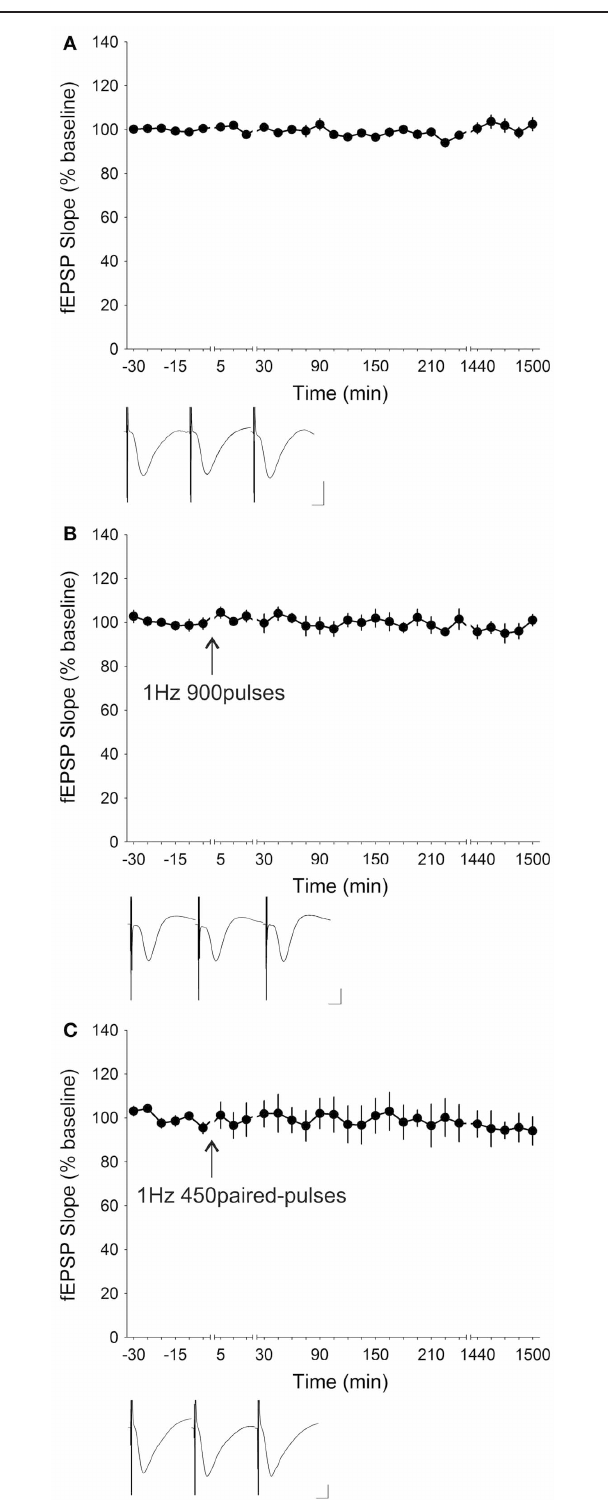
FIGURE 2 | Low-frequency stimulation at 1Hz did not induce synaptic depression at the mouse Schaffer collateral–CA1 synapses in vivo . (A) When no external patterned stimulation was applied, the mice ( n = 18)